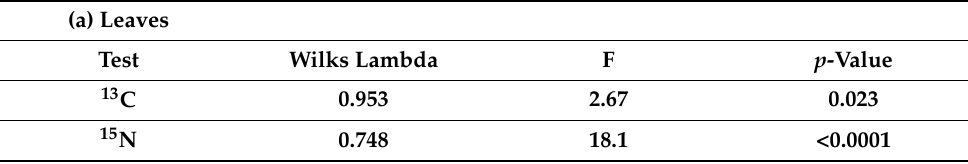
Table 1. ( a ) Foliar variables effect in GDA analysis in leaves. ( b ) Foliar variables effect in GDA analysis in litter. Significant effects ( p < 0.05) are highlighted in bold type.